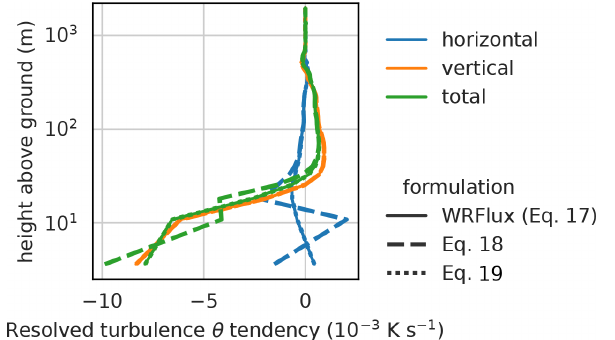
Figure 5. Profiles of resolved turbulence θ tendency over the slope at x =− 5km, for the averaging period between 3.5 and 4h after initialization resulting from flux derivatives in the x (blue) and z (orange) directions and their sum (green). The line styles indicate different formulations for the horizontal flux derivatives (explained in Sect.